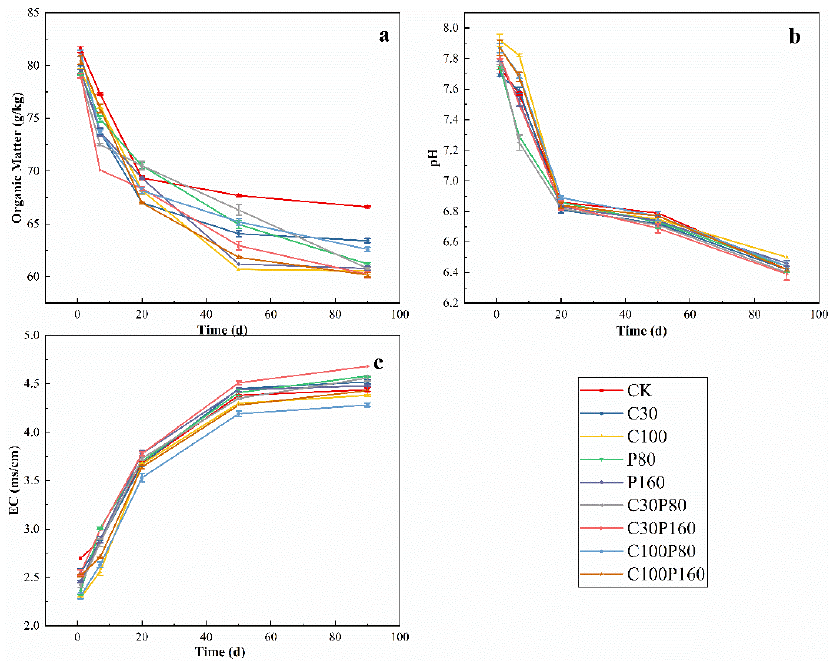
Figure 1. Physicochemical properties of soil, ( a ) organic matter, ( b ) pH, and ( c ) EC.